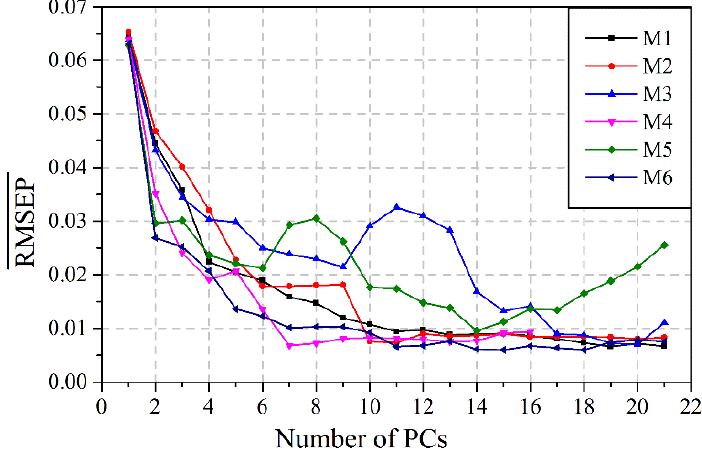
Figure 7. RMSEP̅̅̅̅̅̅̅̅̅ of each feature subset against the number of